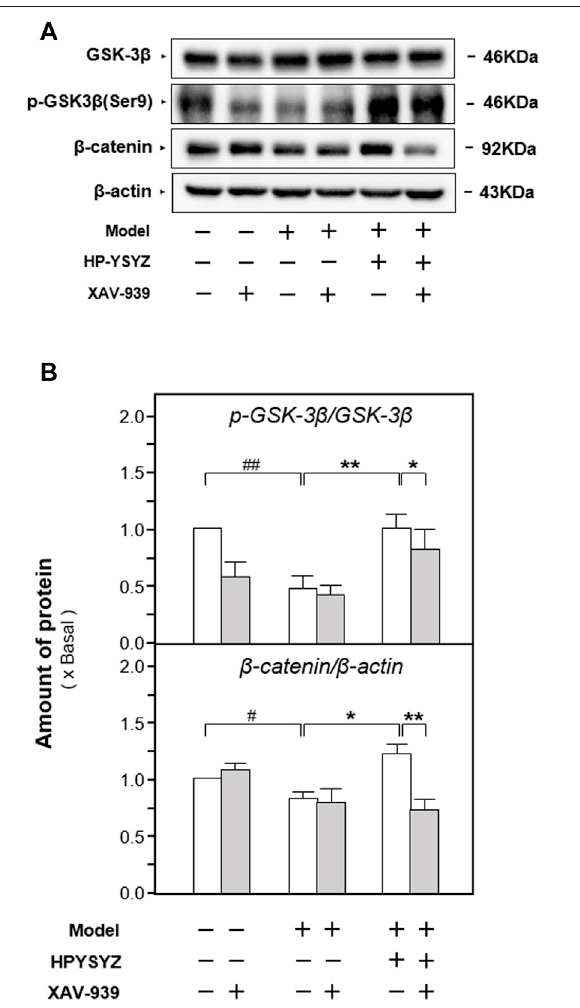
FIGURE8| Effectofco-treatmentofXAV-939andethylacetateextracts of succinum on the GSK3 β / β -catenin pathway of hippocampus of carotid artery ligation rats. (A) Effect of ethyl acetate extracts of succinum (HPYSYZ) on the expressions of GSK3 β , p-GSK3 β (Ser9), β -catenin, p- β -catenin, and β -actin in hippocampus of carotid artery ligation rats after co-treatment of XAV-939 were evaluated by Western blotting analysis. The representative images are displayed ( n = 5). (B) Expression ratio of p-GSK3 β to GSK3 β was calculated, and the expression of β -actin was applied for normalization. Expression ratio of p- β -catenin to β -catenin was calculated, and the expression of β -actin was applied for normalization. Values are expressed as mean±SEM( n =5).Comparisonsbetweengroupswerecarriedoutbyaone- wayANOVAfollowedbya posthoc Bonferronitest. ## p < 0.01,* p < 0.05,and ** p <